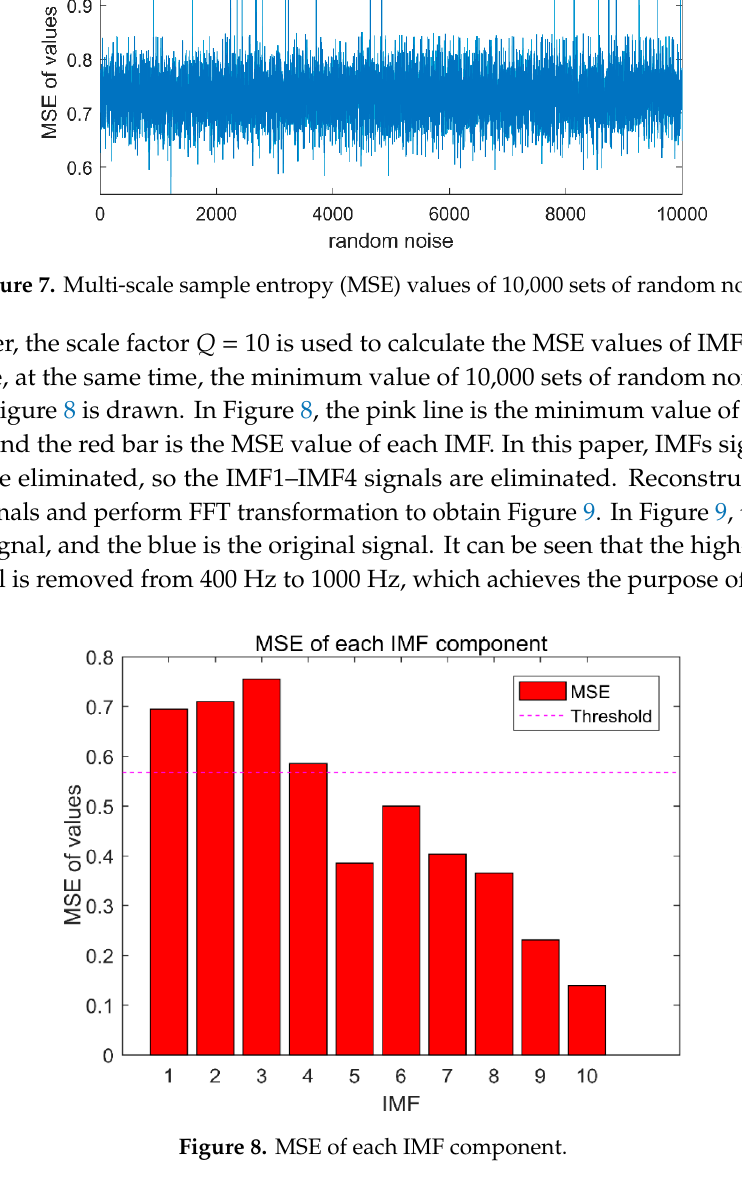
Figure 6. Scale factor Q.